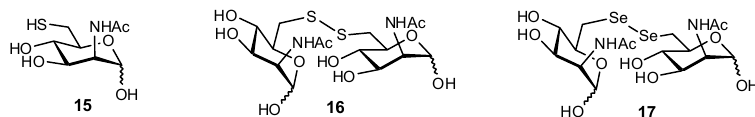
Figure 5. 6- S - and 6- Se -derivatives of ManNAc were synthesized and evaluated as inhibitors of human N -acetylmannosamine kinase (MNK). The high oxidation potential of Se prevented isolation of its monomer [128].